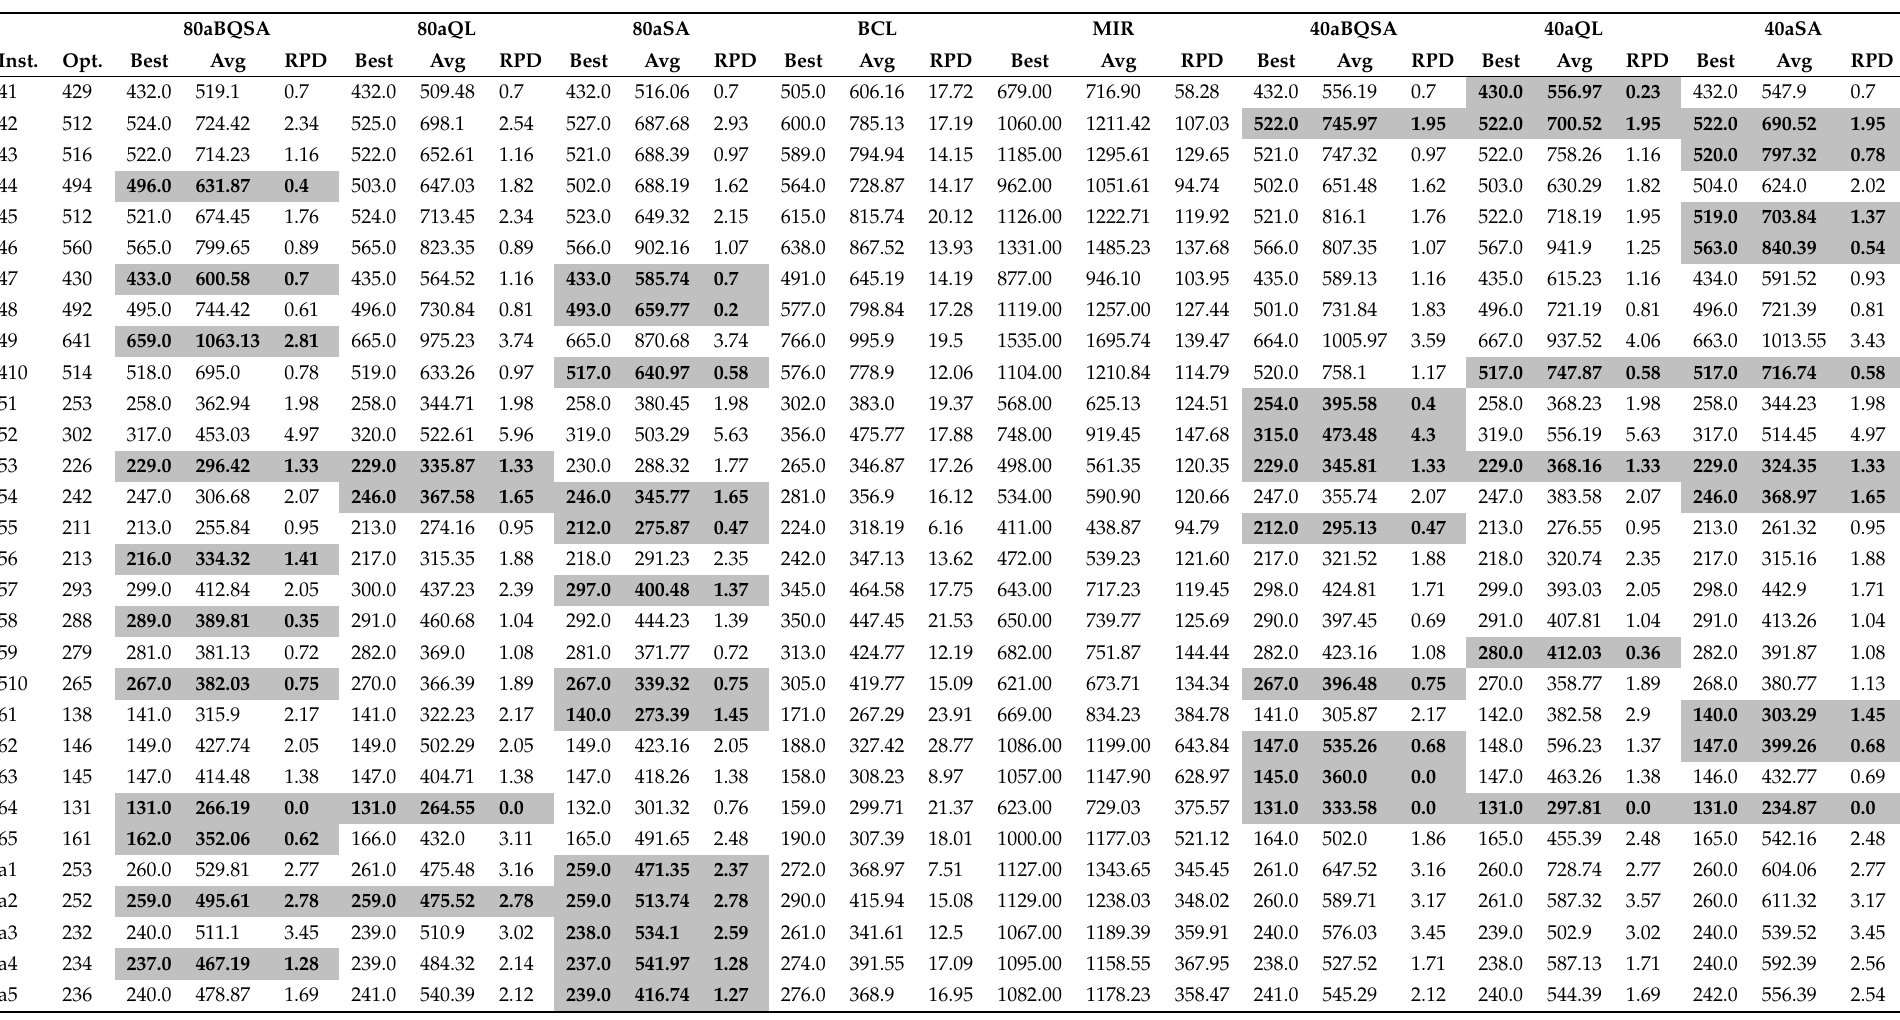
Table 4. Comparison of the metaheuristics